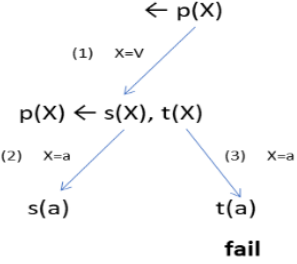
Figure 1. Evaluation tree #1.